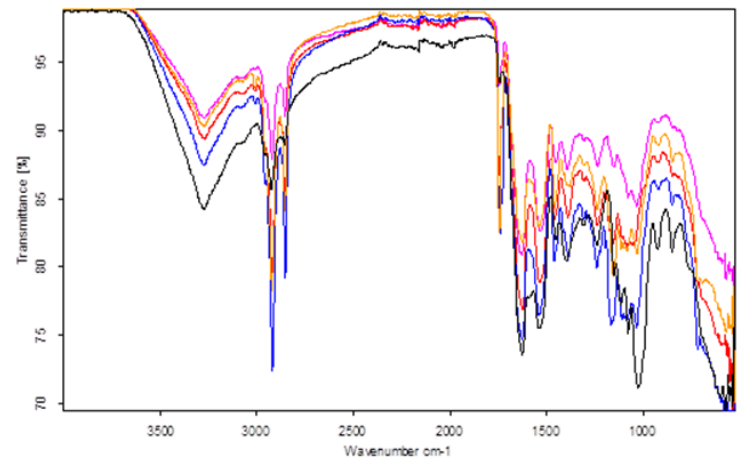
Figure 4. Fourier Transform Infrared Spectroscopy (FT-IR) spectra of boiled-turkey (pink), smoked-turkey (yellow), boiled-pork (orange), roasted-pork (blue), and smoked-pork (green) hams. Specifically, the wide absorption band at 3500–3200 cm −1 is due to Ο-Η and N-H symmetric stretching vibration of alcohols and amide/proteins, respectively. The band from 3100 to 3020 cm −1 is related to the vinyl C-H stretching vibrations of lipids. The strong absorption bands at 2950–2920 and 2852 cm −1 corresponds to methyl and methylene groups’ asymmetric and symmetric stretching vibrations of lipids, respectively. The characteristic band at 1744 cm −1 is assigned to C=O stretching of carbonyl group of triglycerides’ ester bond. Moreover, the strong absorption band at 1627 cm −1 is ascribed to C=O stretching vibration of amides, whereas the band at 1541 cm −1 to the combined vibration of the amino group (N-H) bending with the C-N stretching of proteins. According to Yu [21], the bands in the 1600–1700 and 1500–1560 cm −1 regions represent the protein primary features and are characterized as amide I and amide II, respectively. The weak absorbance band at 1530 cm −1 is related to the COO– asymmetric stretching vibration of fatty acids and proteins. The band at 1467 cm −1 is due to C-H bending of alkyl chain methylene of lipid moieties. The weak bands at 1450 and 1395 cm −1 correspond to C-H asymmetric and symmetric stretching vibrations, respectively, of protein moieties. The strong band from 1170 to 1154 cm −1 is attributed to C-O stretching of proteins and triglycerides. Phospholipids and nucleic acids are characterized by P=O asymmetric and symmetric stretching vibrations at 1240 and 1083 cm −1 , respectively. The medium band at 1117 cm −1 is ascribed to C-H bending and deformation of fatty acids. The bands from 1040 to 1020 cm −1 are assigned to carbohydrate moieties and, in the case of meat products, it might indicate the presence of glycogen. The medium bands at 966 and 870 cm −1 are attributed to the out-of-plane deformation of CH=CH trans double bond and para-disubstituted aromatic derivatives, respectively. From the interpretation of the FT-IR spectra of the ham samples (Table 2) (boiled turkey, smoked turkey, boiled pork, smoked pork, and roasted pork), the most interesting findings concerning the type of meat and processing are summarized below. The spectra of pork samples, irrespective of processing type, showed absorbance bands of higher ( p < 0.05) intensities at 2950–2920, 2852, and 1744 cm −1 than the spectra of the turkey samples. Therefore, it seems that pork hams have a higher ( p < 0.05) lipid content compared to turkey hams. Moreover, since the band at 3100–3020 cm −1 was associated with the vibration of the olefin group, it could be estimated that turkey hams were characterized by higher content of unsaturated fatty acids than the pork hams. An important indication confirming the above finding was the presence of the band at 717 cm −1 only in the turkey-ham samples, which is associated with the out-of-plane bending vibration of the –CH=CH– group in unsaturated fatty acids [22]. Furthermore, pork hams have higher ( p < 0.05) protein content compared to turkey hams, as the spectra of pork hams exhibited higher ( p < 0.05) intensities at 1450, 1395, and 1170–1154 cm −1 than the ones of the turkey samples. In this sense, the adsorption bands at 1627 and 1541 cm −1 , which are characteristics of the protein